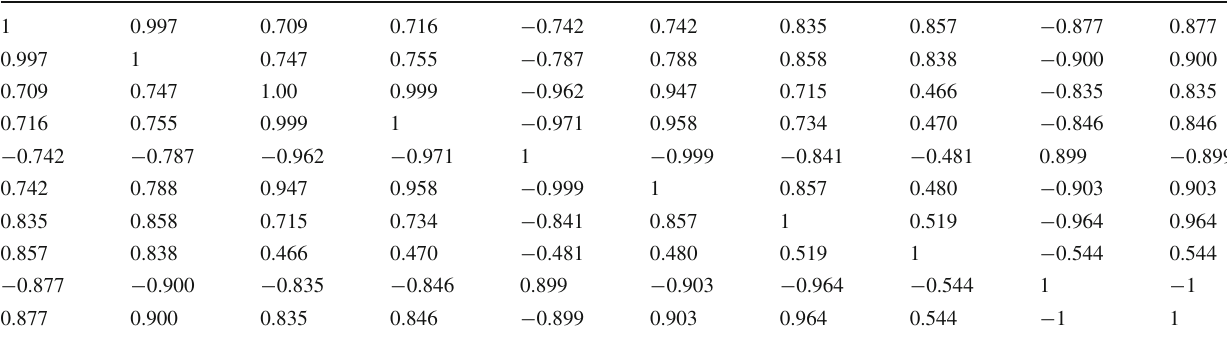
Table 7 Correlation matrix for the (cid:2) b → (cid:2)μ − τ +